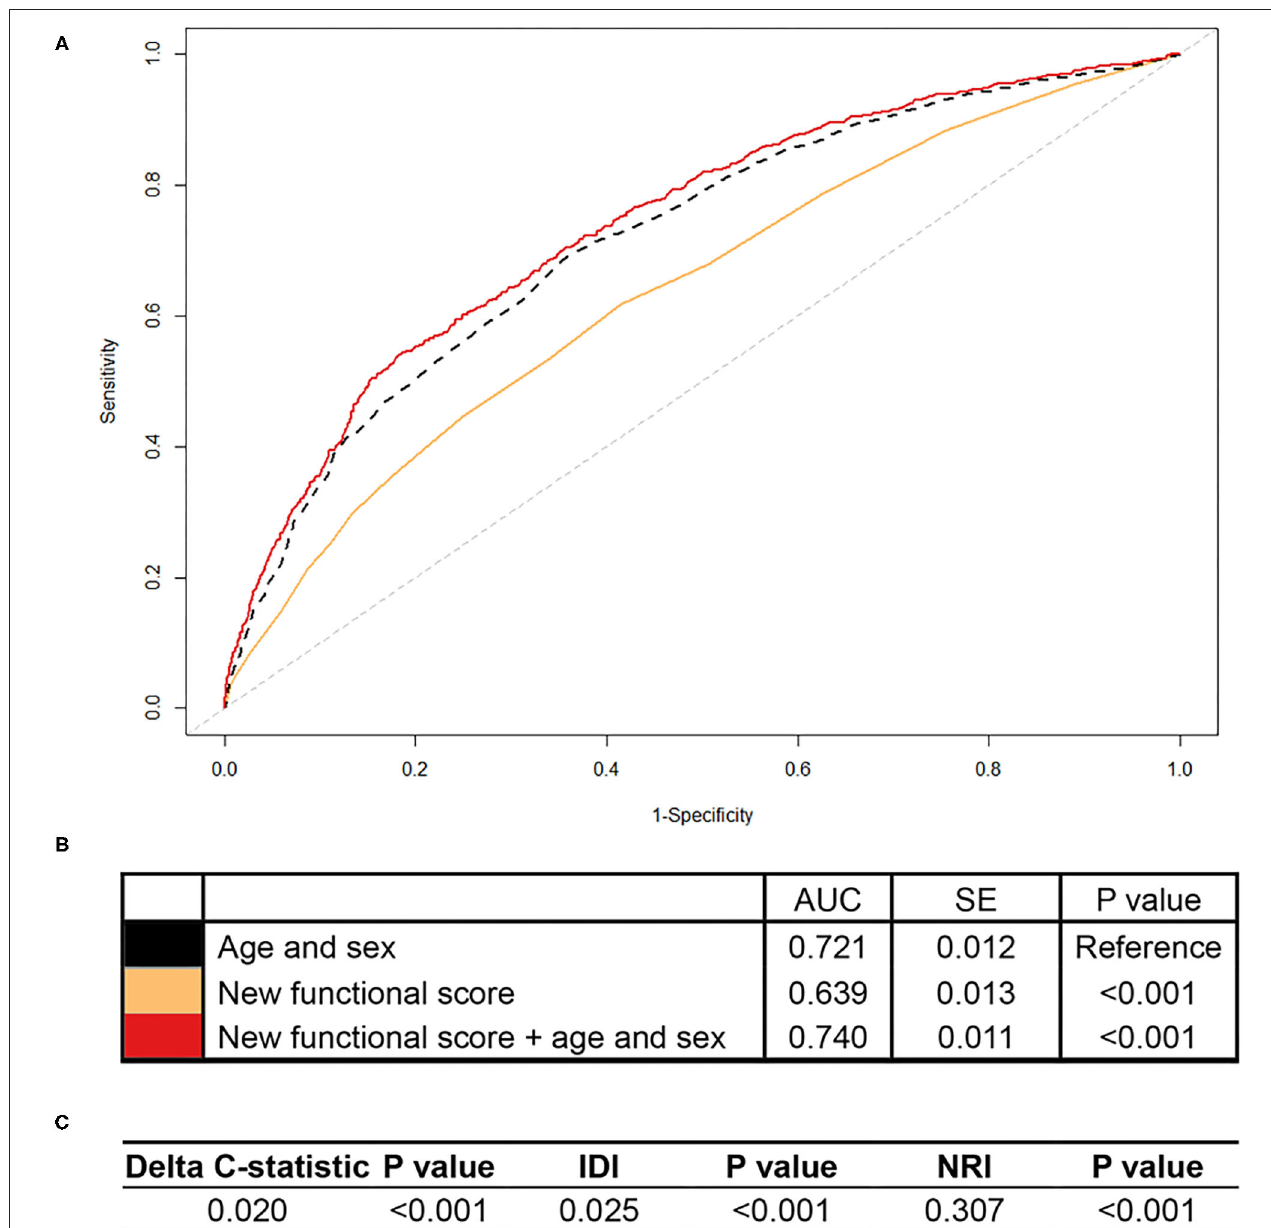
FIGURE 1 | Association of the new functional score with all-cause mortality in CHARLS. CHARLS, China Health and Retirement Longitudinal Study; AUC, area under the curve; SE, standard error; IDI, integrated discrimination improvement; NRI, net reclassification index. We calculated the continuous NRI and IDI using R package “PredictABEL,” in comparison to that of the basic model with age and sex. NRI equals to x% means that compared with persons without outcome, persons with outcome were almost x% more likely to move up a category than down. IDI equals to x% means that the difference in average predicted risks between the persons with and without the outcome increased by x% in the updated model. (A) Shows receiver-operator characteristics curves for prediction of all-cause mortality for the new functional score. (B) Shows the AUC for each model. (C) Shows delta C-statistic, IDI, and NRI, in comparison to that of the basic model with age and